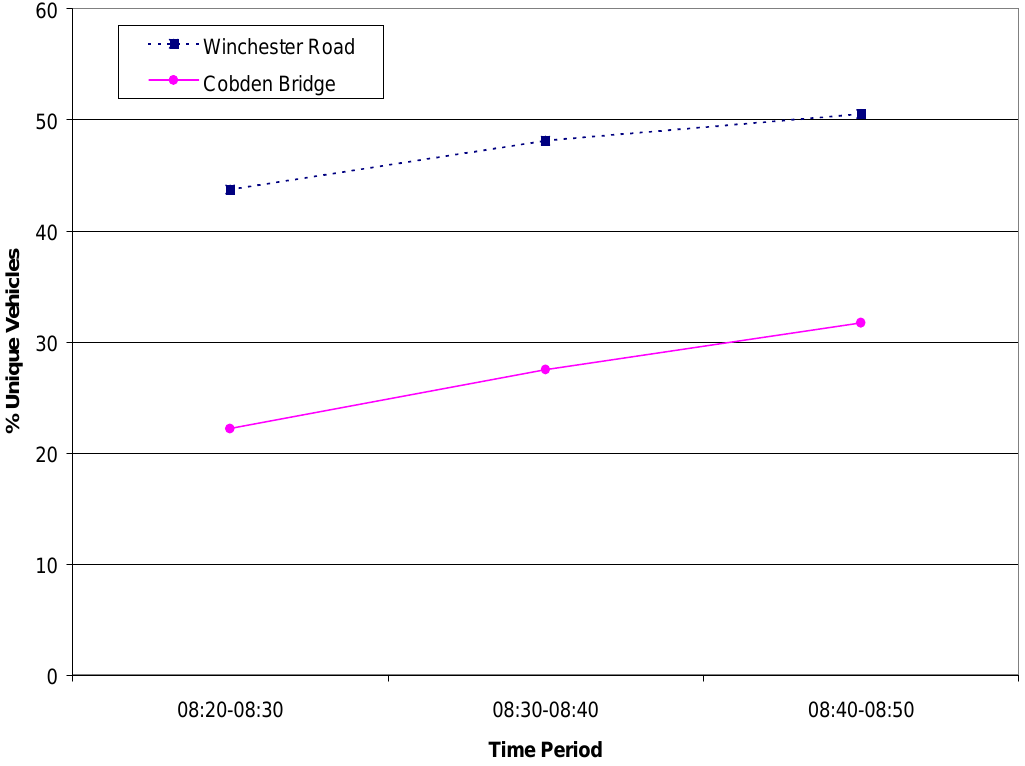
Figure 2. The mean percentage of vehicles from time slices 08:20-08:30, 08:30-08:40 and 08:40-08:50 which were unique to each day in the 1994 Winchester Road and Cobden Bridge surveys (i.e. never re-appearing again at any time during the survey